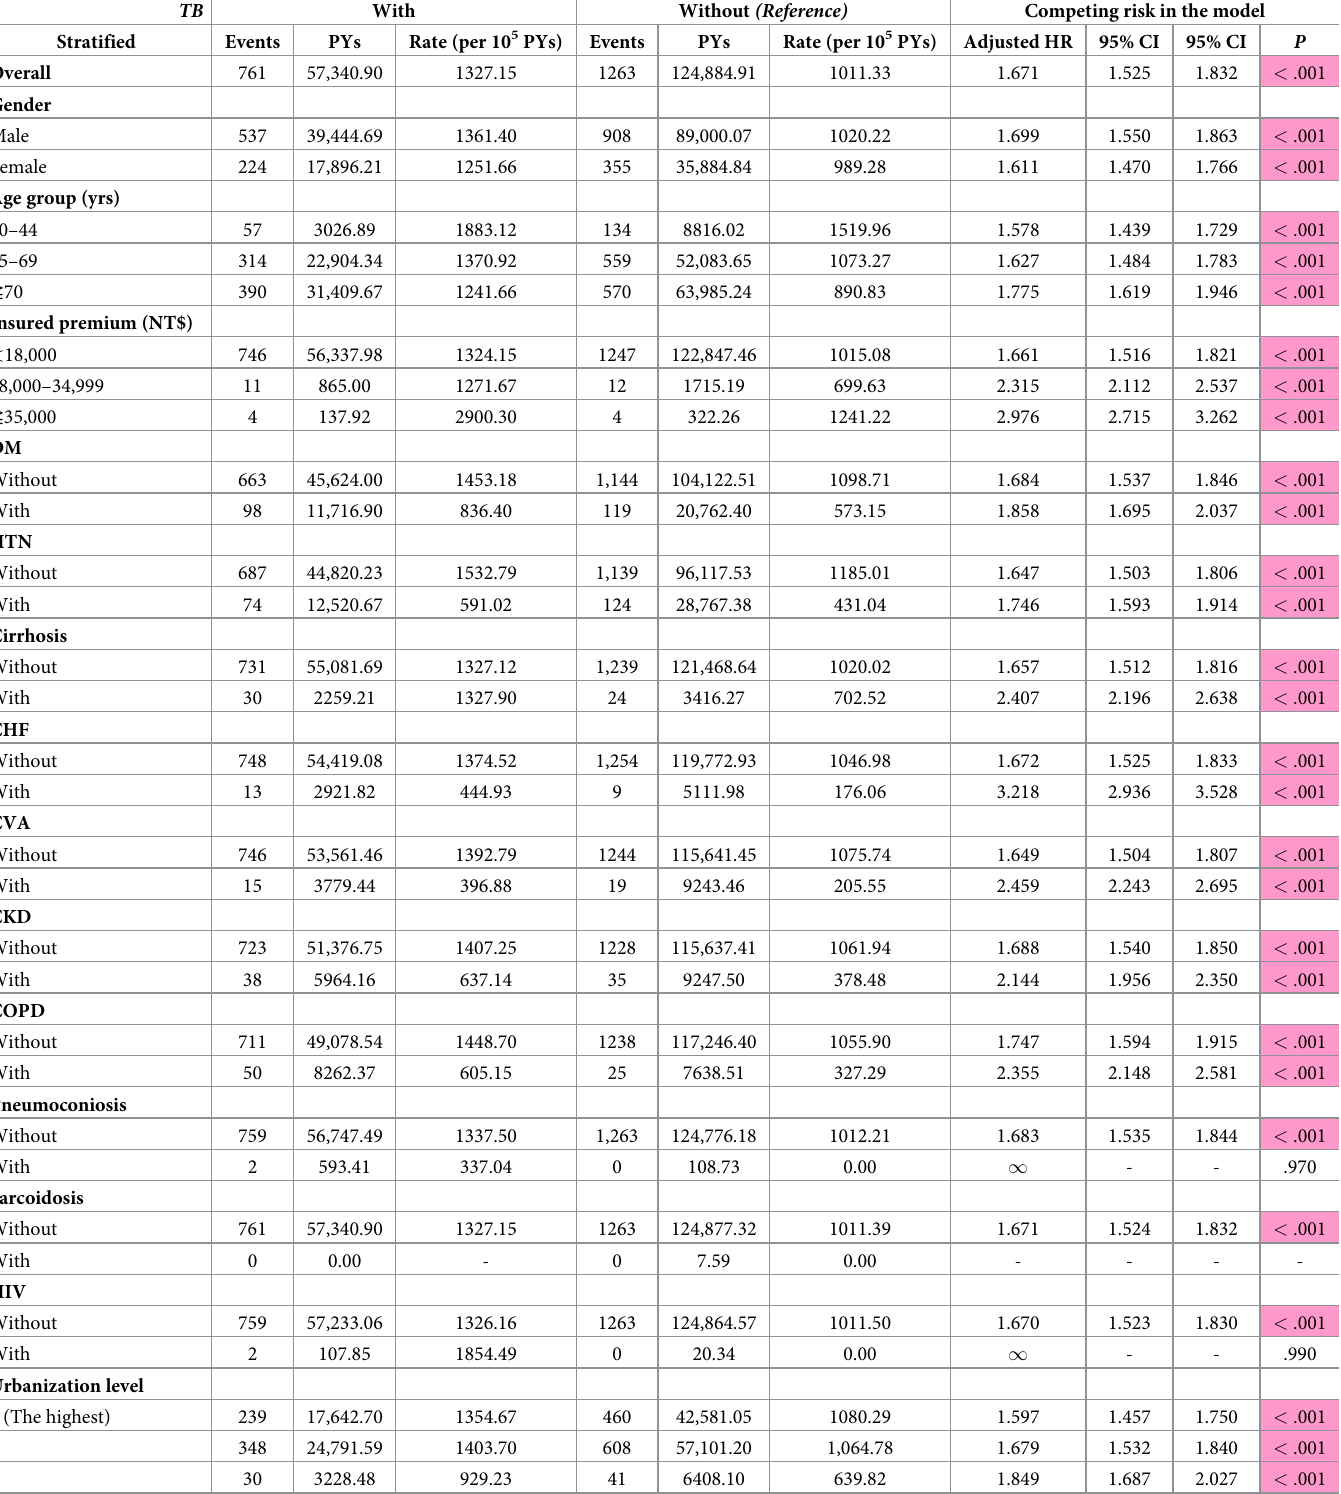
Table 3. Factors of secondary lung cancer stratified by variables listed using Cox regression and Fine & Gray’s competing risk model. TB With Without (Reference) Competing risk in the model